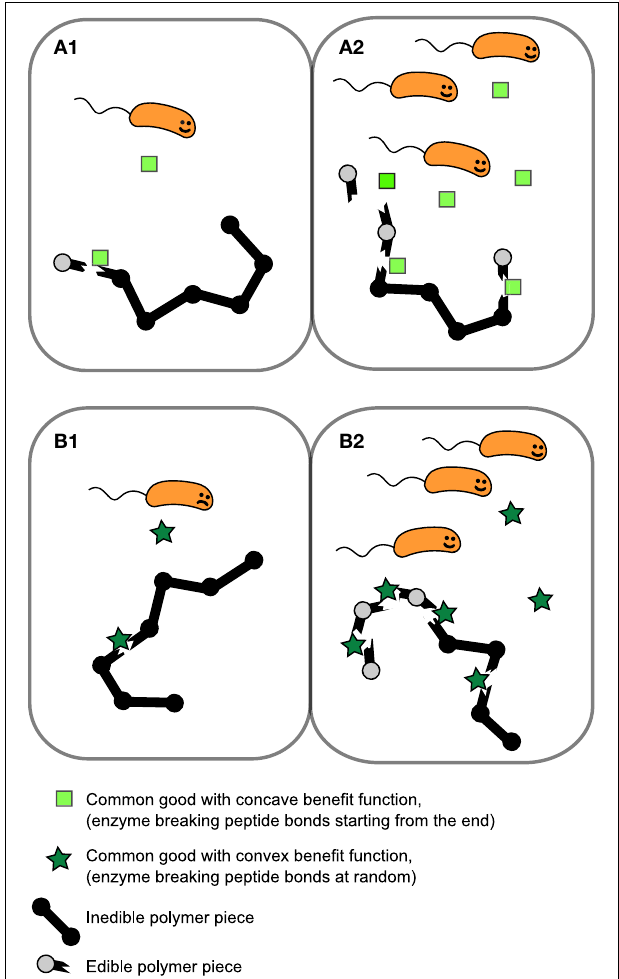
FIGURE 2 | Example of public goods with differently shaped benefit functions. Proteases which works extracellularly by degrading polymers that are too large to be transported over the cell membrane can either break the peptide bonds of the polymer starting from the end of the polymer (exoprotease) or target a range of specific types of peptide bond within the chain, effectively breaking bonds at random (endoprotease). In this scenario benefit is proportional to the probability of yielding “edible” pieces of polymer. (A1,A2) Benefit increases approximately linearly with exoprotease concentration resulting in an initially concave benefit function. (B1,B2) The probability of breaking the polymer at a site producing an piece small enough to transport over the cell membrane is low when enzyme concentration is low, but accelerates as endoprotease concentration increases, resulting in a initially convex benefit